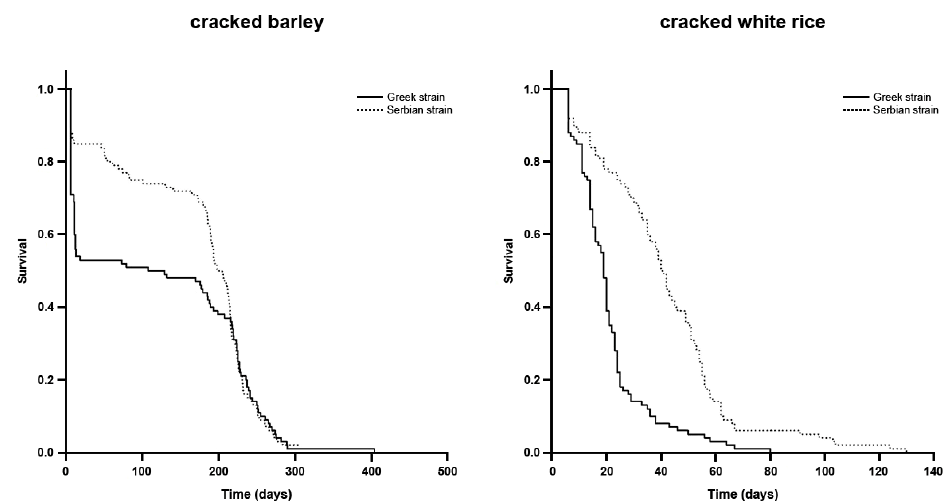
Figure 1. Survival curves of two Tribolium confusum strains fed on cracked barley and cracked white rice. Table 2. Survival times (mean ± SE) in days of two strains of Tribolium confusum fed on cracked barley and cracked white rice. Cracked barley means followed by different uppercase letter are statistically different (95% C.I.). Cracked white rice means followed by different lowercase letter are statistically different (95% C.I.).